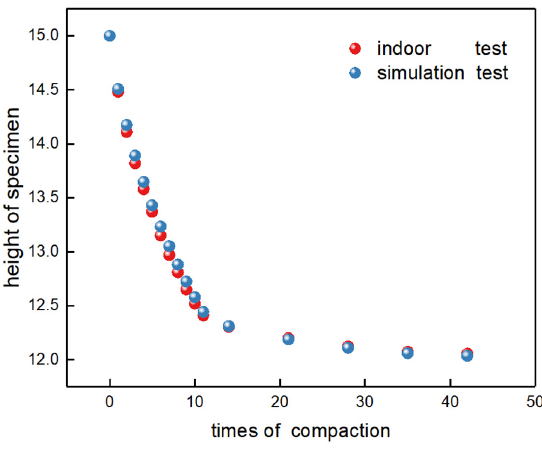
Figure 4. Comparison of tamping settlement between the indoor compaction test and the discrete element simulation test.